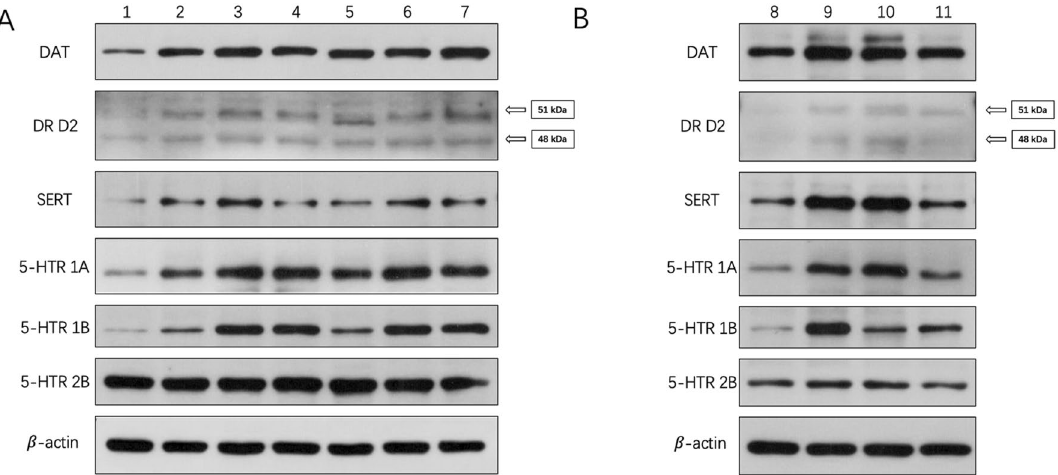
Figure 3. Effects of sulpiride and clozapine on the translation levels of functional proteins involved in DAergic and 5-HTergic systems in zebrafish telencephalon. Lane 1, control; lanes 2–4, 20, 50, and 100 ng/L sulpiride, respectively; lanes 5–7, 20, 50, and 100 ng/L clozapine, respectively; lane 8, control; lanes 9–11, 20, 50, and 100 ng/L sulpiride and clozapine mixture, respectively. The grouping of blots was first cropped from different gels and then transferred onto PVDF membranes (1:1) prior to hybridisation with antibodies.